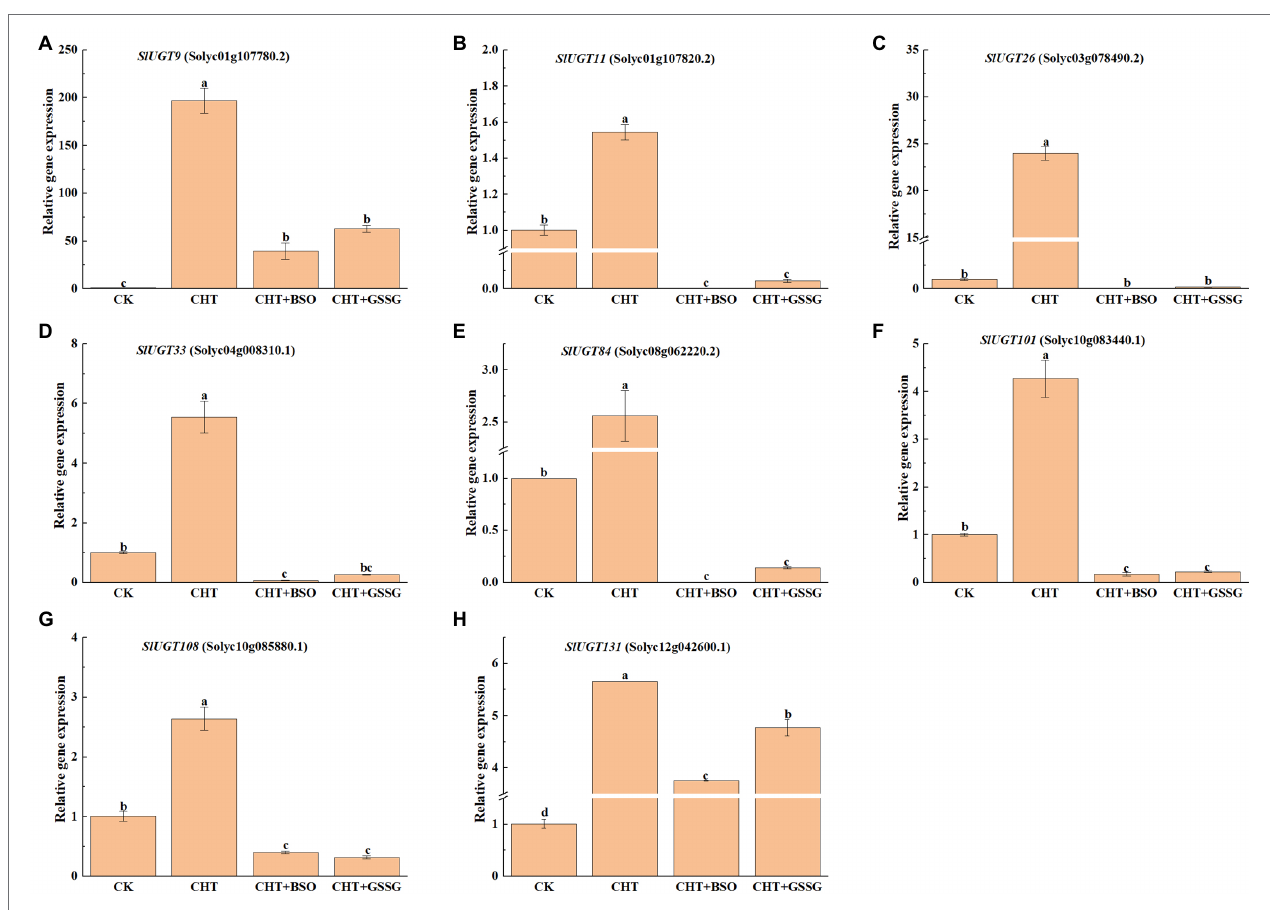
FIGURE 11 | Expression profiles of eight representative SlUGT genes in response to different treatments. (A) SlUGT9 expression. (B) SlUGT11 expression. (C) SlUGT26 expression. (D) SlUGT33 expression. (E) SlUGT84 expression. (F) SlUGT101 expression. (G) SlUGT108 expression. (H) SlUGT131 expression. Error bars represented the SD ( n = 3). According to Duncan’s multiple tests, bars with different letters were significantly different ( p <